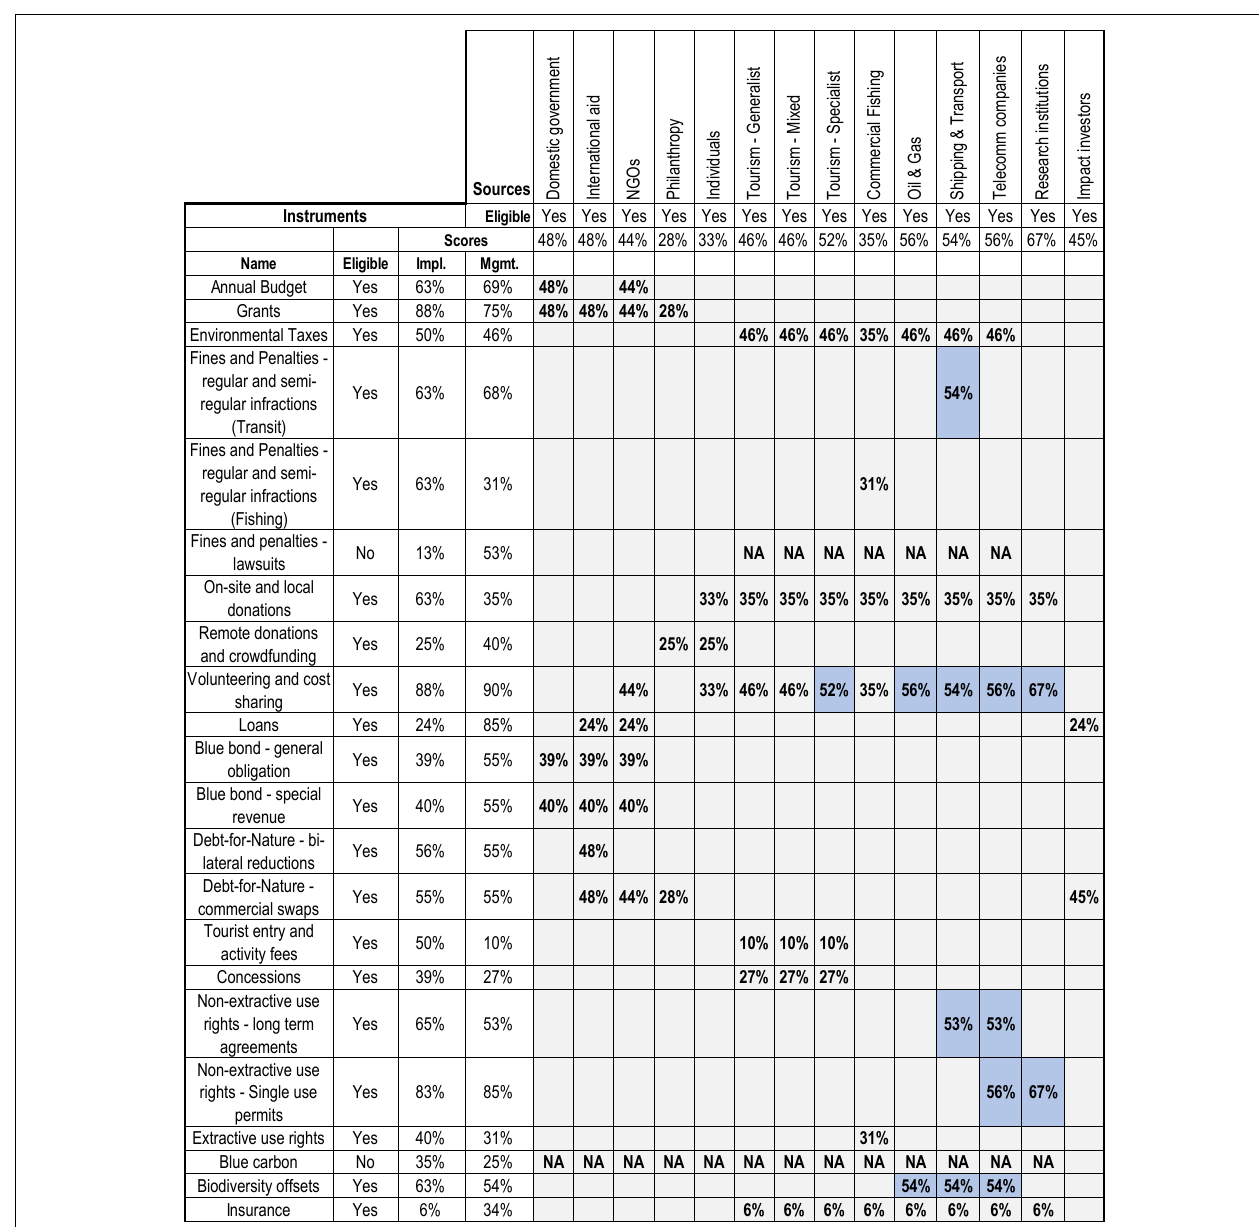
FIGURE 7 | Results matrix for PNN CPR indicating scores for potential financial mechanisms as pairs of sources of finance and financial instruments. Scores equal to or above 50% are shaded in blue.